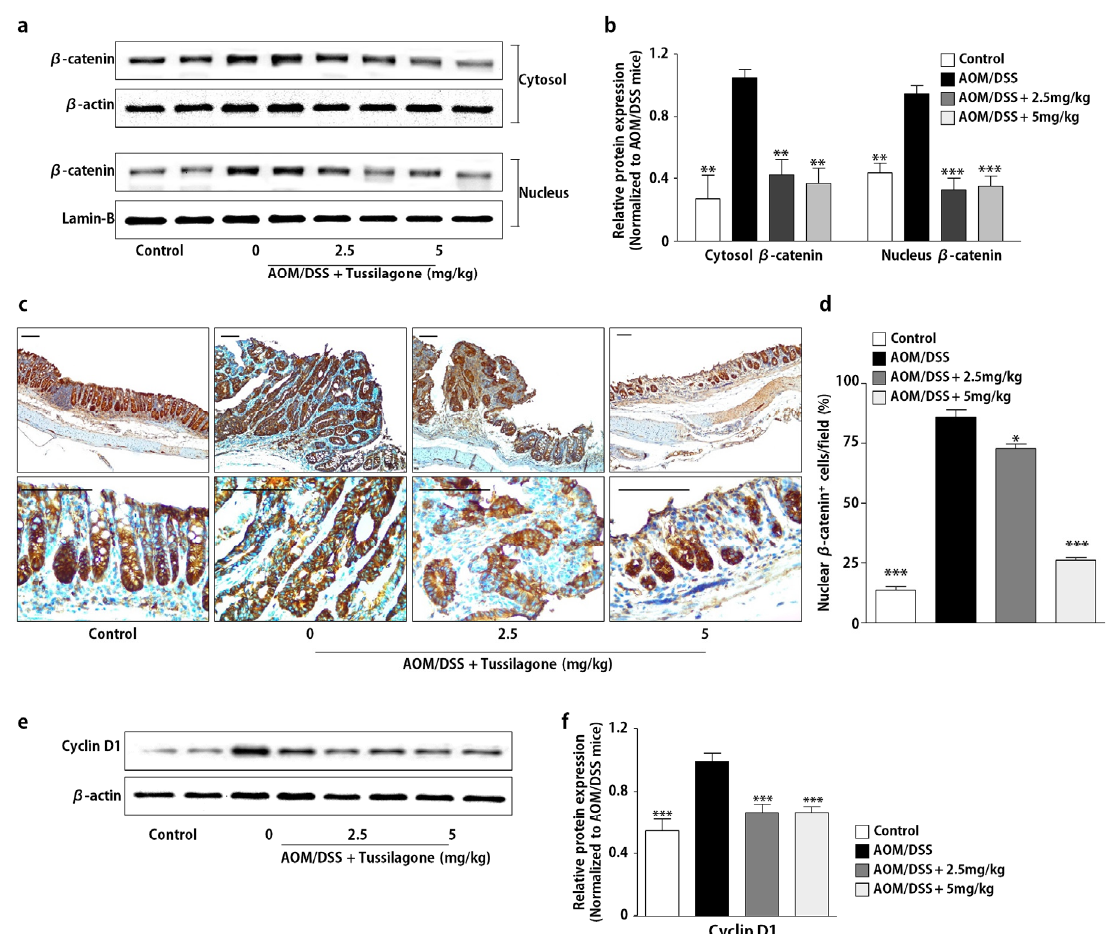
Figure 5. Administration of tussilagone inhibits the β -catenin expression in the colon tissues. ( a ) The protein samples in the cytosol or nuclear fraction from the colon tissues were separated by SDS-PAGE. β -catenin was detected by Western blot and visualized by chemiluminescence. Photos are representative images. ( b ) The quantitative data were normalized by internal control ( β -actin for cytosol; lamin-B for nuclear fraction) and further expressed as folds, presented as the comparison with the amount relative to the AOM / DSS-treated mice. ( c ) The immunohistochemical analysis of nuclear β -catenin expression in the colon tissues (upper, × 100 magnification; lower, × 400 magnification; bar = 100 µ m). ( d ) The percentage of nuclear β -catenin positive cells in the colon tissues was calculated as described in Methods. ( e ) The protein samples of the whole-cell lysates from the colon tissues were separated by SDS-PAGE. Cyclin D1 was detected by Western blot and visualized by chemiluminescence. Photos are representative images. ( f ) The quantitative data were normalized by internal control, β -actin and further expressed as folds, presented as the comparison with the amount relative to the AOM / DSS-treated mice. The results are expressed as the mean ± SEM, * P < 0.05, ** P < 0.01, *** P < 0.001, compared with the AOM / DSS-treated